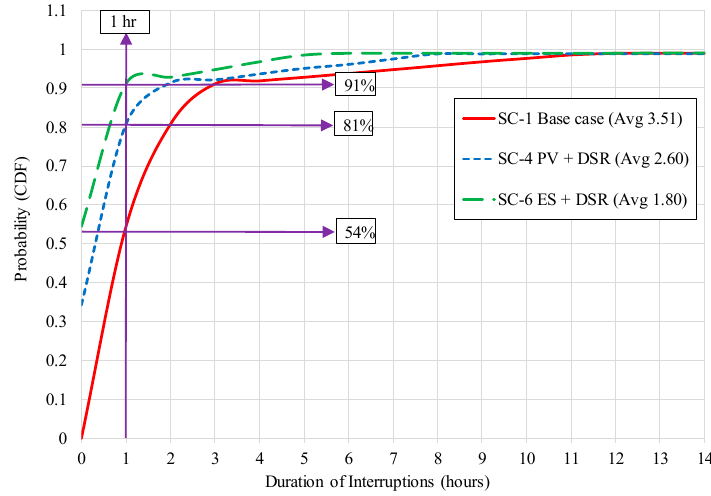
Figure 15. Comparison of CDFs illustrating the impact on the duration of interruptions.